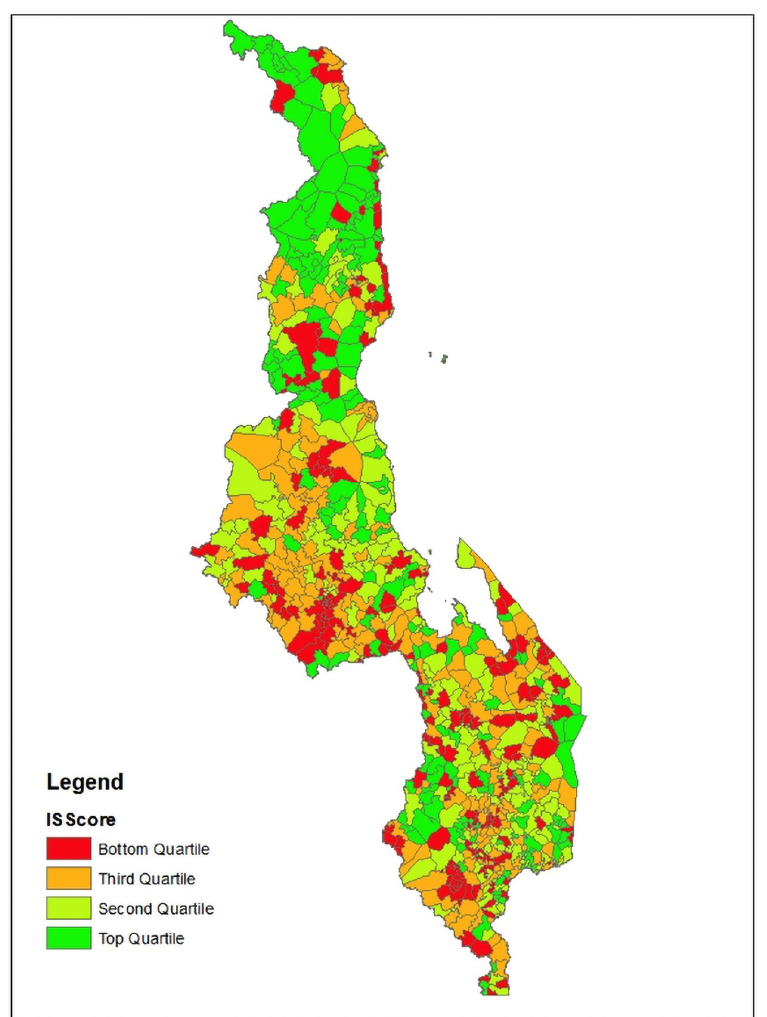
Fig 2. Heat map of IS scores within each DHS cluster across